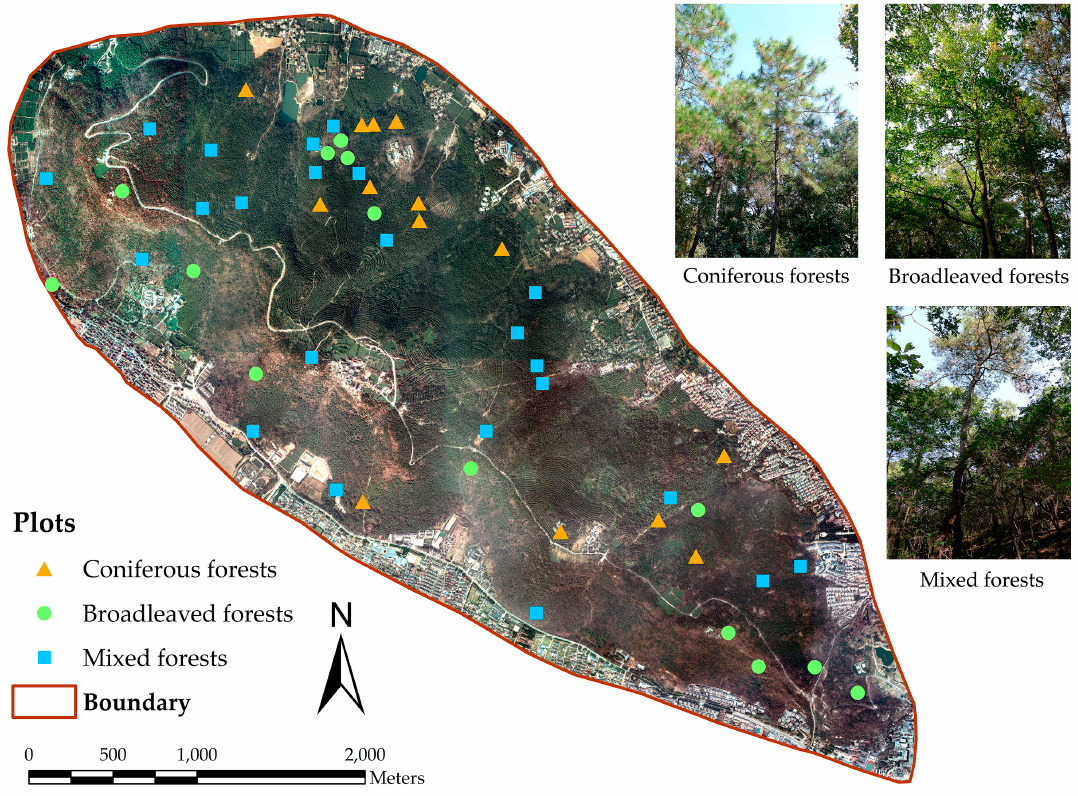
Figure 2. Aerial photograph of Yushan Forest and the distribution of field plots, as well as the field photos of the three typical forest types in the study site.